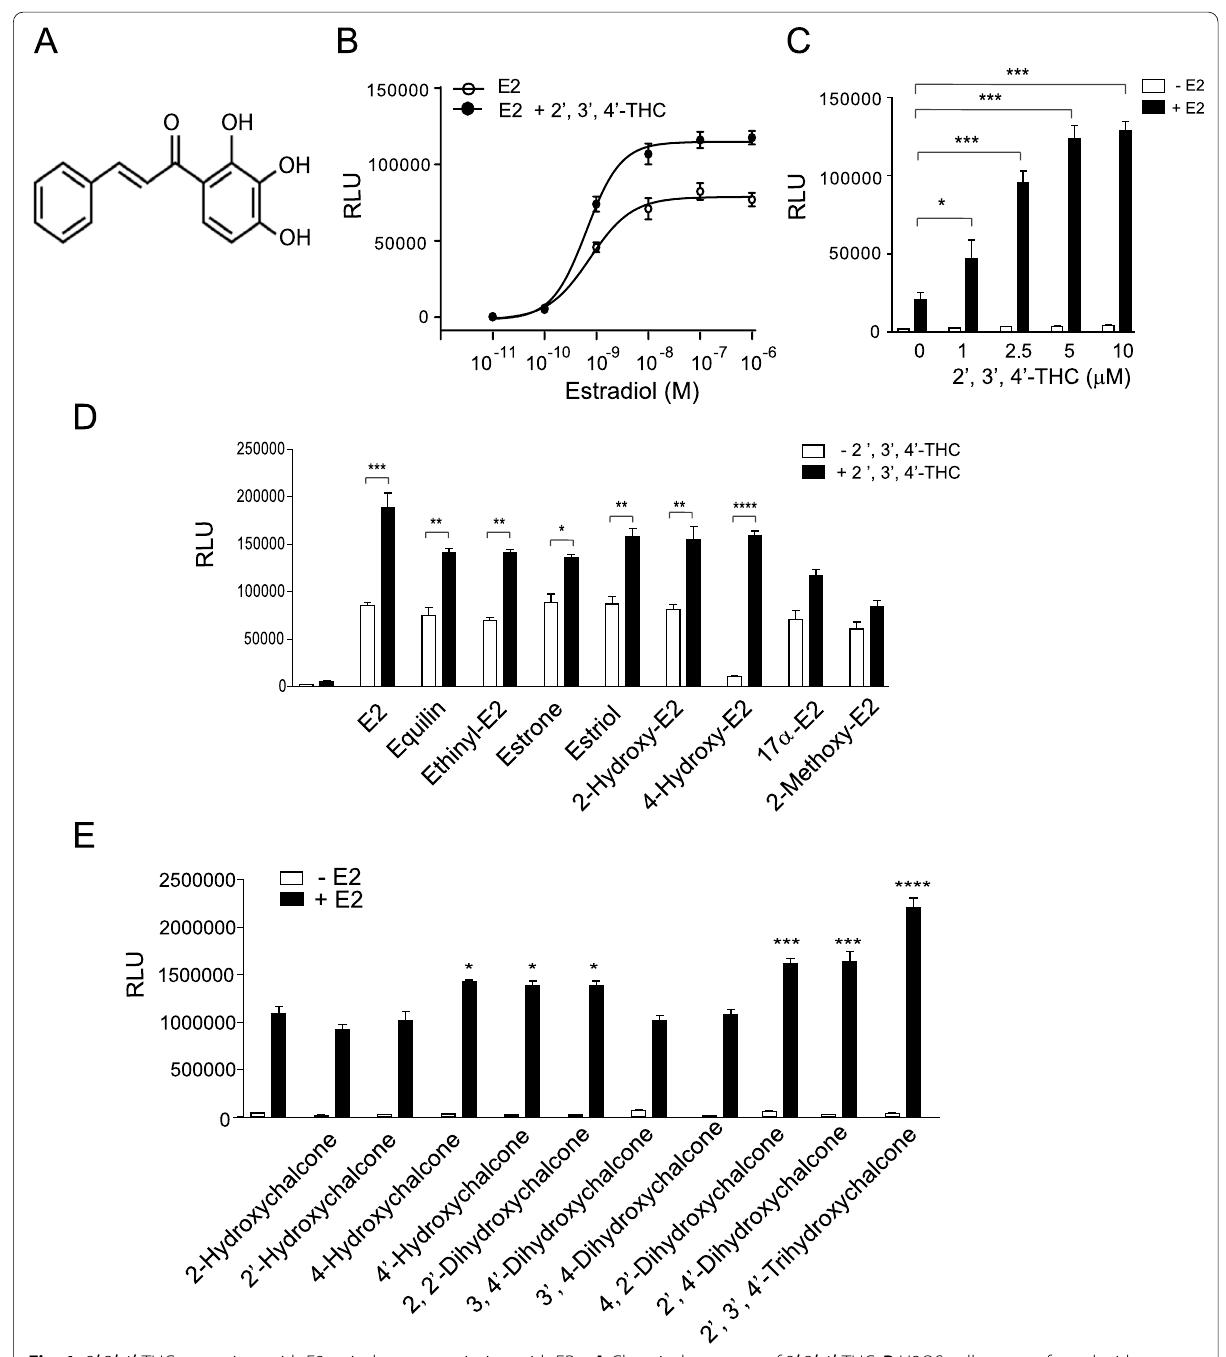
Fig. 1 2 ′ ,3 ′ ,4 ′ ‑THC synergizes with E2 to induce transcription with ERα. A Chemical structure of 2 ′ ,3 ′ ,4 ′ ‑THC. B U2OS cells cotransfected with ERE‑TK‑Luc and ERα were treated with increasing concentrations of E2 in the absence and presence of 5 μM 2 ′ ,3 ′ ,4 ′ ‑THC for 24 h. The average RLU for the control cells was 2551 and the 2 ′ ,3 ′ ,4 ′ ‑THC treated cells was 2650. C U2OS cells cotransfected with NKG2E‑TK‑Luc and ERα were treated with increasing concentrations of 2 ′ ,3 ′ ,4 ′ ‑THC in the absence and presence of 10 nM E2 for 24 h. D U2OS cells cotransfected with NKG2E‑TK‑Luc and ERα were treated with 10 nM E2 or 100 nM of the other estrogens in the absence and presence of 5 μM 2 ′ ,3 ′ ,4 ′ ‑THC for 24 h. E U2OS cells cotransfected with NKG2E‑TK‑Luc and ERα were treated with 5 μM of each chalcone in the absence or presence of 10 nM E2 for 24 h. Luciferase activity was measured in cellular lysates with a luminometer. RLU is relative light units. Each point in the figures represents the mean of triplicate samples C, D The asterisks indicate statistical significance between the two groups analyzed by t‑test. E The asterisks over the bars indicate the significant difference between E2 alone and E2 in combination with the chalcone as analyzed by